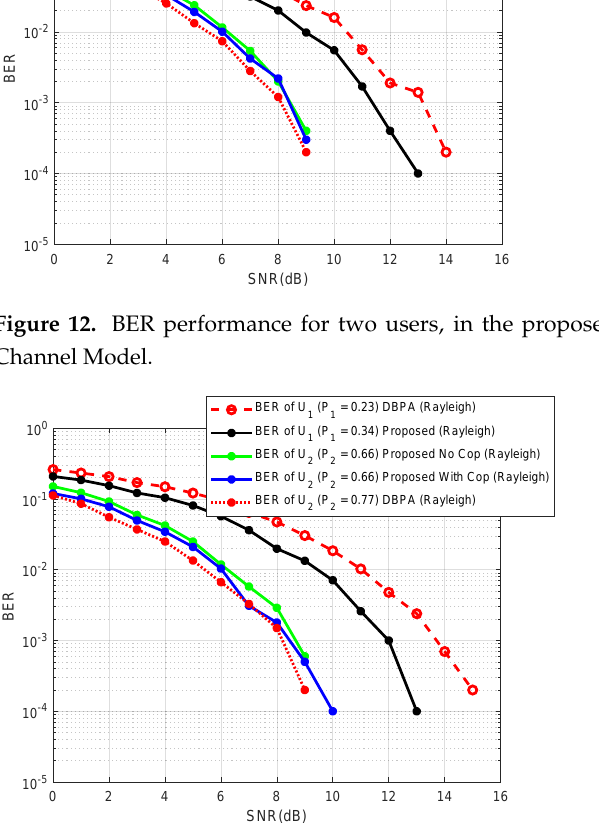
Figure 13. BER performance for two users, in the proposed FIS based model in Rayleigh (SUI-6) Channel